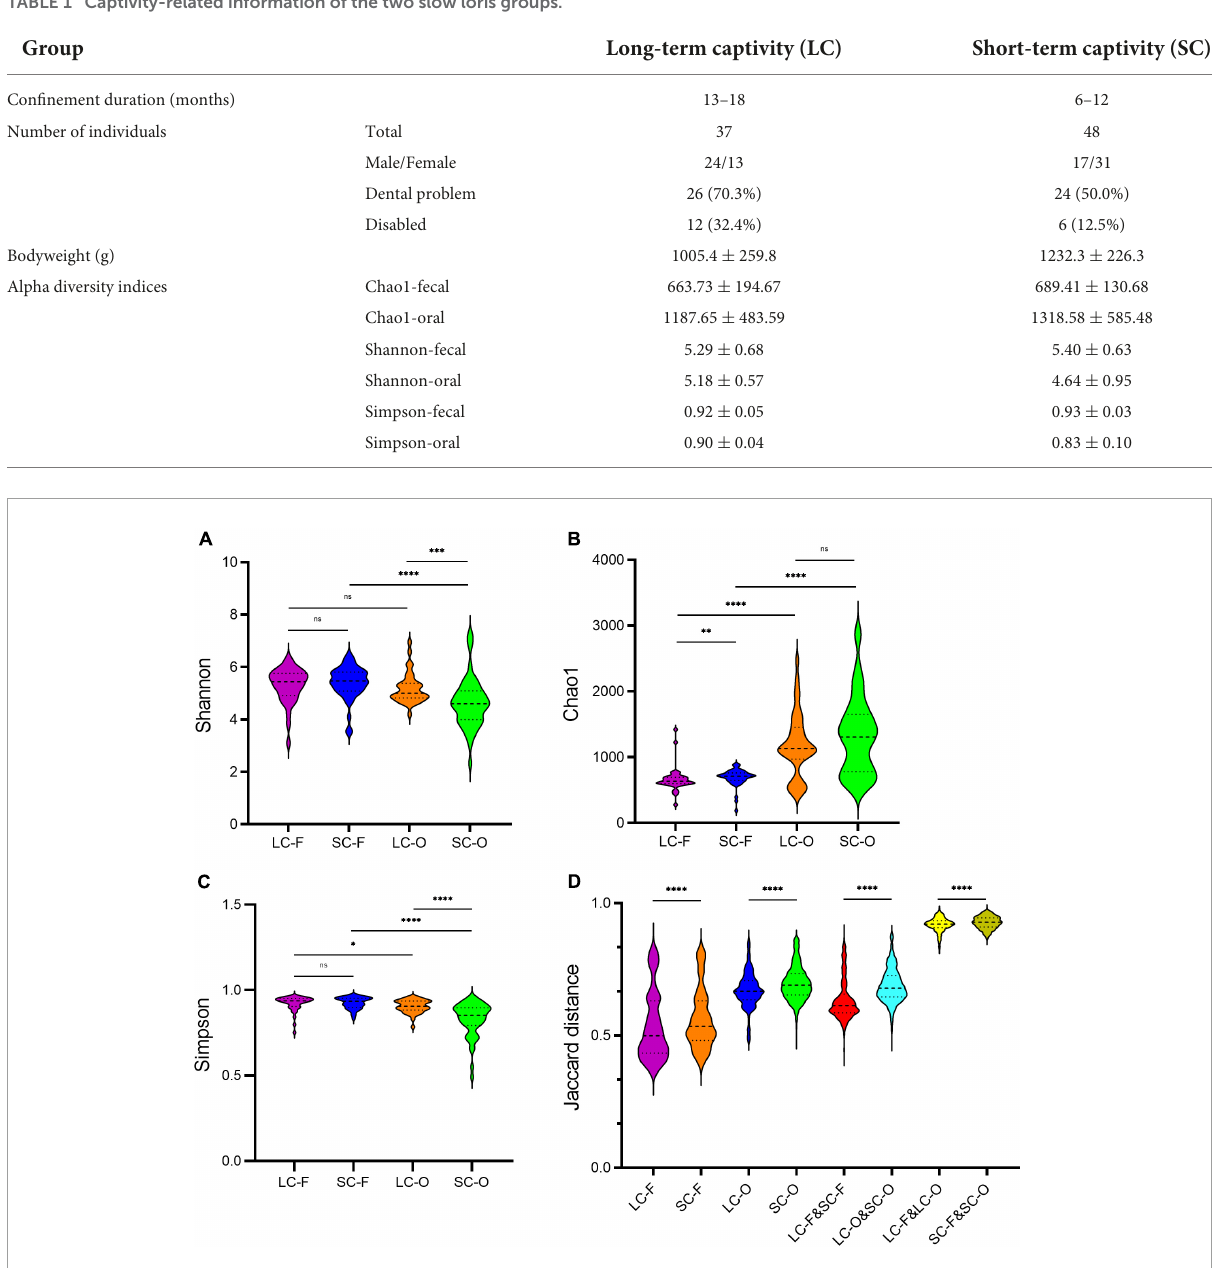
TABLE 1 Captivity-related information of the two slow loris groups.